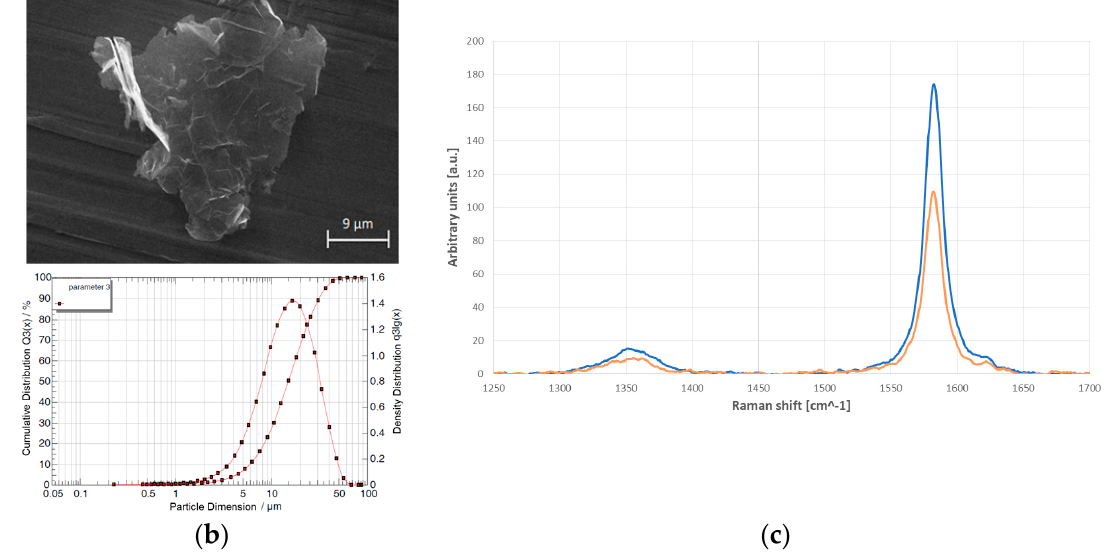
Figure 1. GnPs characterization: ( a ) SEM image of a single nanoplatelet of graphite; ( b ) particle size analysis of GnPs, as provided by the supplier; and ( c ) representative Raman spectra of GnPs before (blue line) and after (orange line) the electrodeposition process.